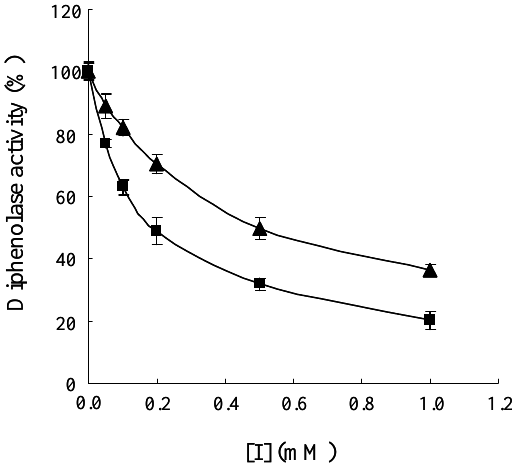
Figure 7. Effects of diflunisal ( ■ ) and indomethacin ( ▲ ) on the diphenolase activity of mushroom tyrosinase. L -DOPA was incubated with mushroom tyrosinase with or without diflunisal of indomethacin as described in the Experimental